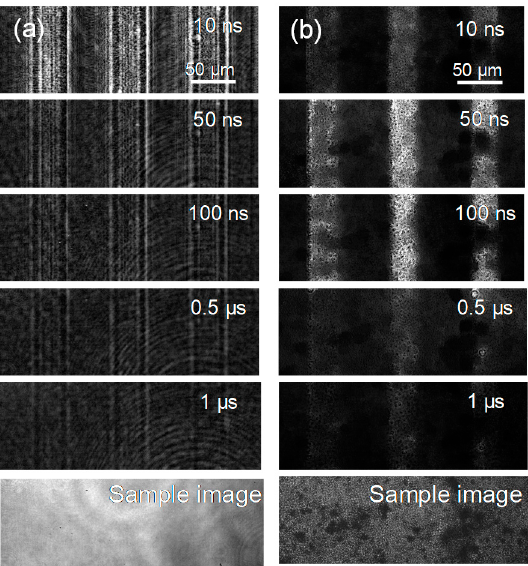
Figure 4. The PI-PM image sequences for ( a ) a single crystal and ( b ) a particulate film of SrTiO 3 are shown. The sample images obtained under the same optical setup are also shown at the bottom of each sequence.